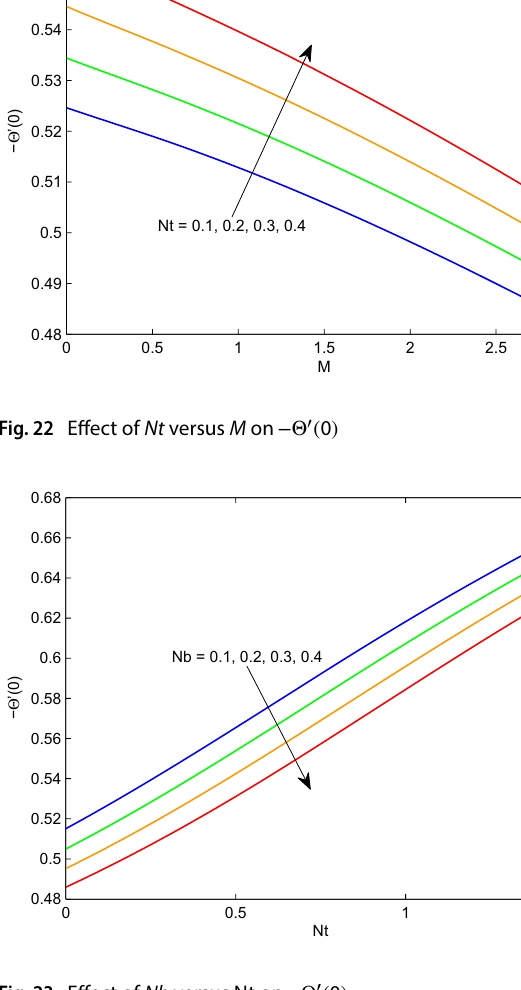
Fig. 23 Effect of Nb versus Nt on −Θ � ( 0 )